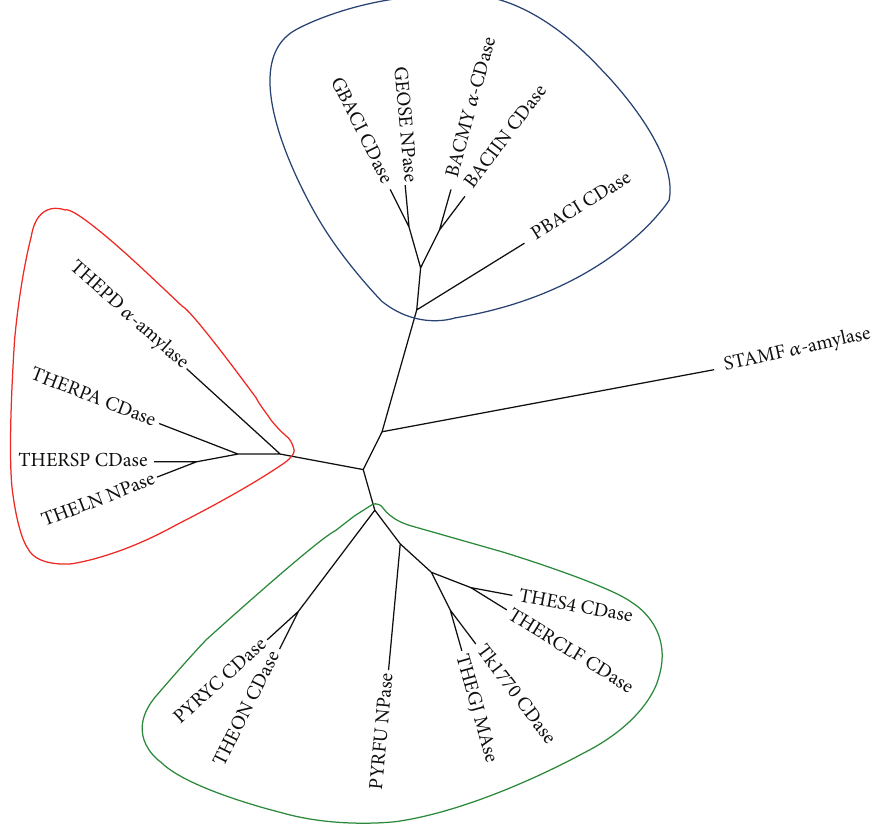
Figure 2: Phylogenetic tree: rooted radial tree of 17 CD hydrolyzing enzymes was constructed using MrBayes with Wag rate matrix (fixed) and visualized using FigTree. The phylogenetic tree obtained displays three distinct clades. All the bacterial enzymes form a single clade (shown in blue), while the branch for archeal enzymes split into two clades (shown in green and red). Depending upon sequence identity and domain arrangement Tk1770 CDase seems to be more closely related to THEGJ MAse, THES4 CDase, THERCLF CDase, PYRFU NPase, THEON CDase, and PYRYC CDase